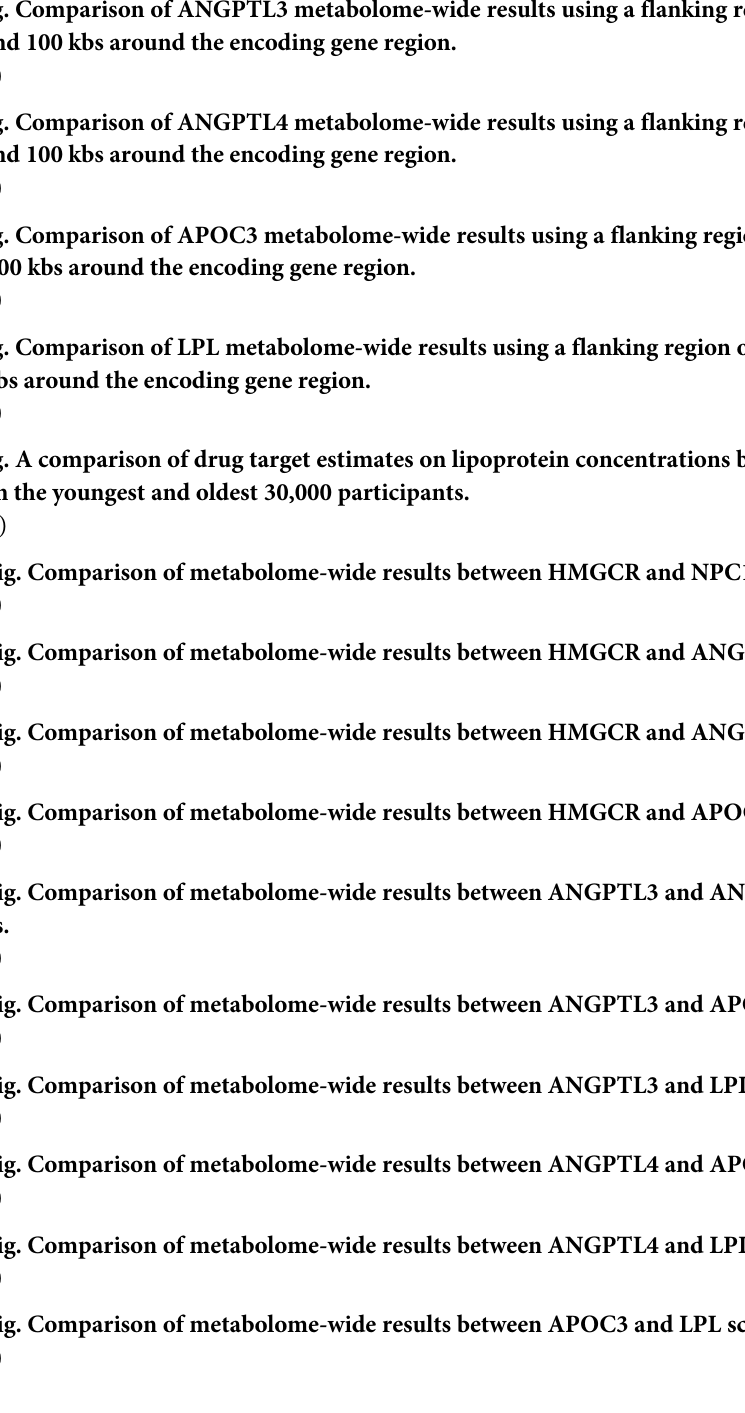
S4 Fig. Comparison of CETP metabolome-wide results using a flanking region of 50 kbs and 100 kbs around the encoding gene region. (PDF) S5 Fig. Comparison of ANGPTL3 metabolome-wide results using a flanking region of 50 kbs and 100 kbs around the encoding gene region. S6 Fig. Comparison of ANGPTL4 metabolome-wide results using a flanking region of 50 kbs and 100 kbs around the encoding gene region. S7 Fig. Comparison of APOC3 metabolome-wide results using a flanking region of 50 kbs and 100 kbs around the encoding gene region. S8 Fig. Comparison of LPL metabolome-wide results using a flanking region of 50 kbs and 100 kbs around the encoding gene region. S9 Fig. A comparison of drug target estimates on lipoprotein concentrations between anal- yses in the youngest and oldest 30,000 participants. S10 Fig. Comparison of metabolome-wide results between HMGCR and NPC1L1 scores. (PDF) S11 Fig. Comparison of metabolome-wide results between HMGCR and ANGPTL3 scores. (PDF) S12 Fig. Comparison of metabolome-wide results between HMGCR and ANGPTL4 scores. (PDF) S13 Fig. Comparison of metabolome-wide results between HMGCR and APOC3 scores. (PDF) S14 Fig. Comparison of metabolome-wide results between ANGPTL3 and ANGPTL4 scores. S15 Fig. Comparison of metabolome-wide results between ANGPTL3 and APOC3 scores. (PDF) S16 Fig. Comparison of metabolome-wide results between ANGPTL3 and LPL scores. (PDF) S17 Fig. Comparison of metabolome-wide results between ANGPTL4 and APOC3 scores. (PDF) S18 Fig. Comparison of metabolome-wide results between ANGPTL4 and LPL scores. (PDF) S19 Fig. Comparison of metabolome-wide results between APOC3 and LPL scores.